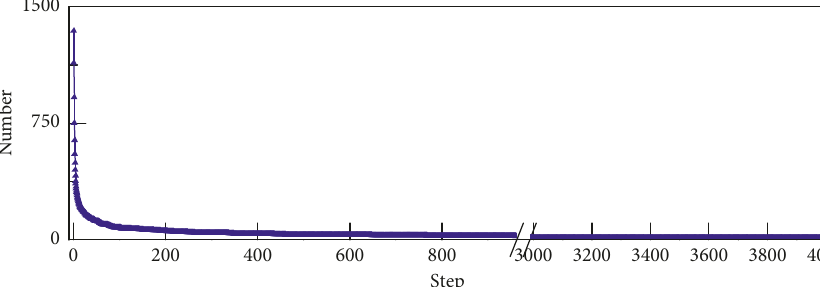
Figure 5: The number of minima at different numbers of scale